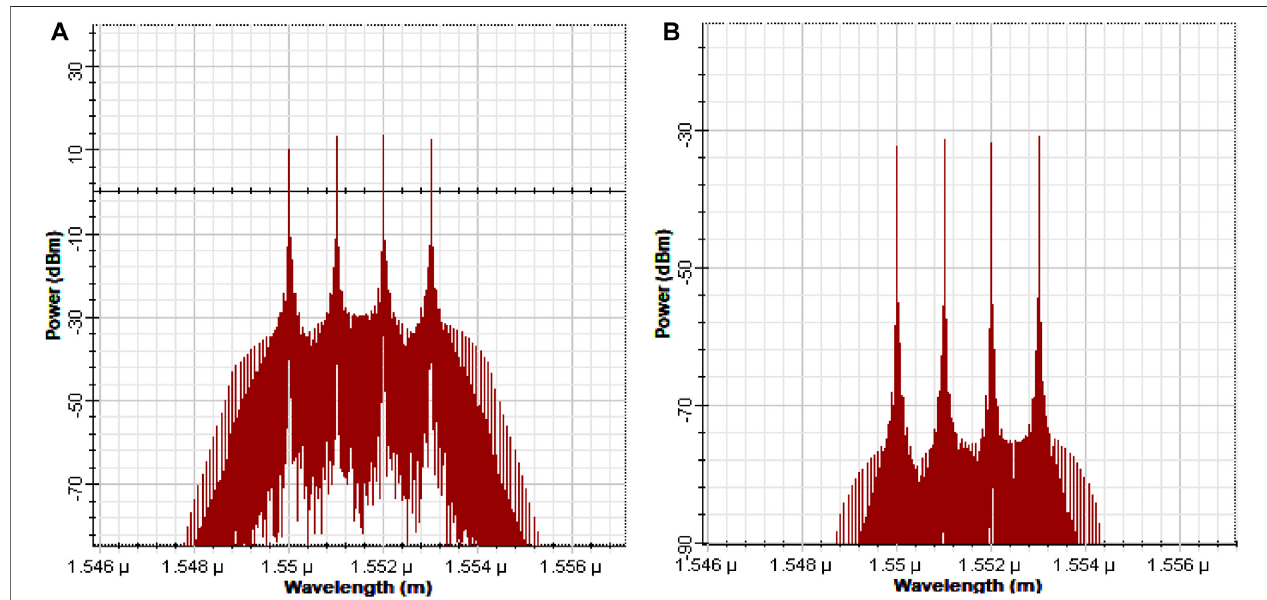
FIGURE 6 | The spectrum of signal (A) transmitter section and (B) receiver